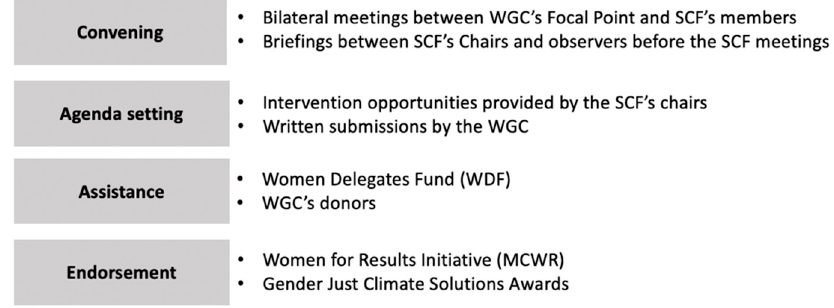
Figure 2. Existing orchestration approaches to support the engagement of women organisations in climate finance decision-making under the UNFCCC (developed by the author).